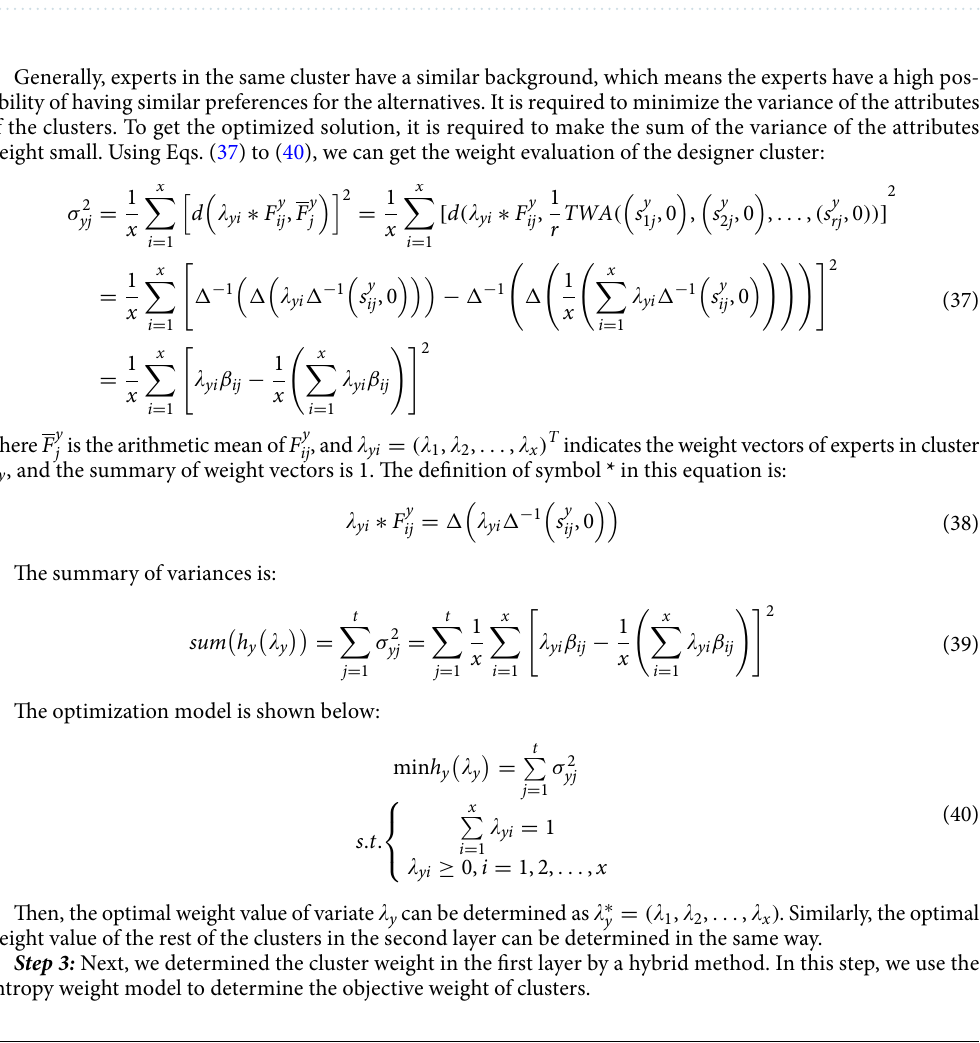
Table 4. Form of the data recorded in the table based on pairwise comparative